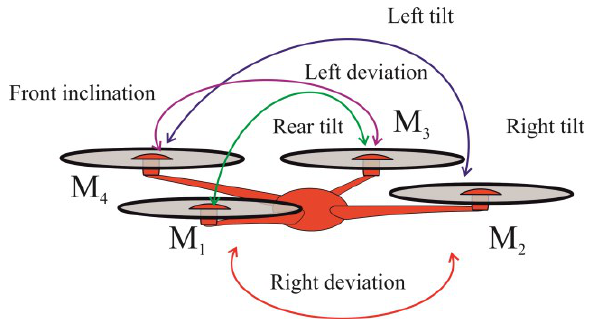
Fig. 1. Model of the UAV control